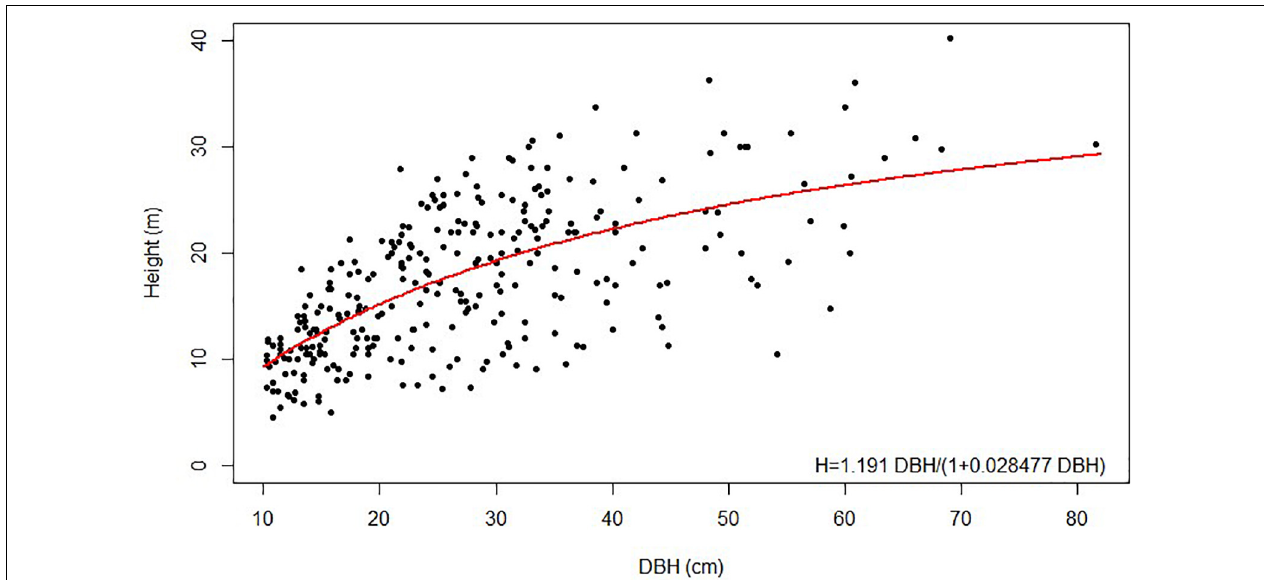
FIGURE 5 | Height (m) and DBH (cm) of measured trees in Sierra del Tigre, showing best-fit model (red line).